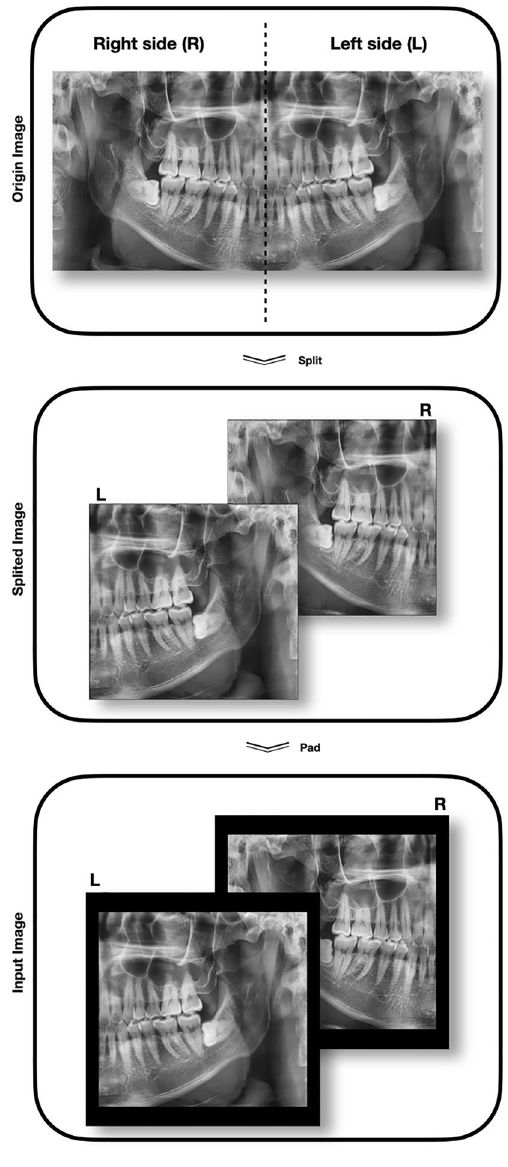
Figure 4. Preprocessing of panoramic